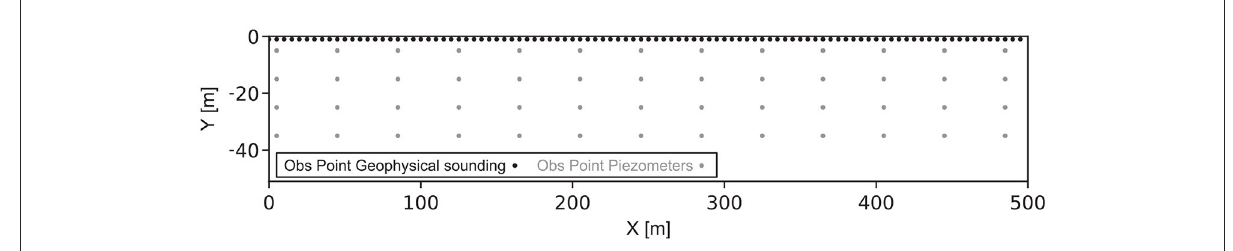
FIGURE5 Location of the geophysical and hydrogeological observation points. The river is located at the position (500,0).